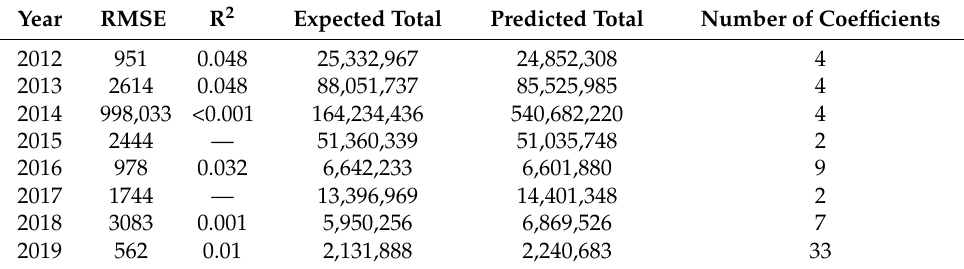
Table 3. GLM regression prediction results.